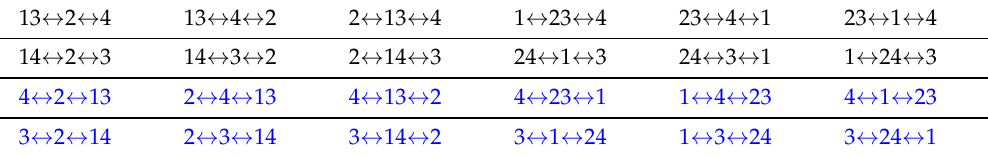
Table 6. Possible chamber interconnection schemes of VDN with linear topology and shared cham- bers in dual cylinder crane application. Blue colored combinations represent redundant interconnec- tion